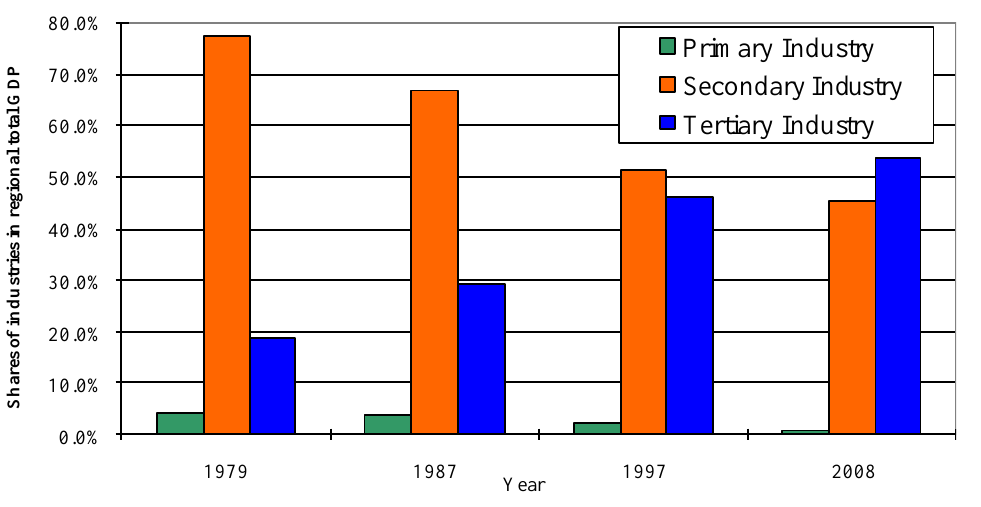
Figure 4. Shares of industries in total GDP during 1979 and 2008.